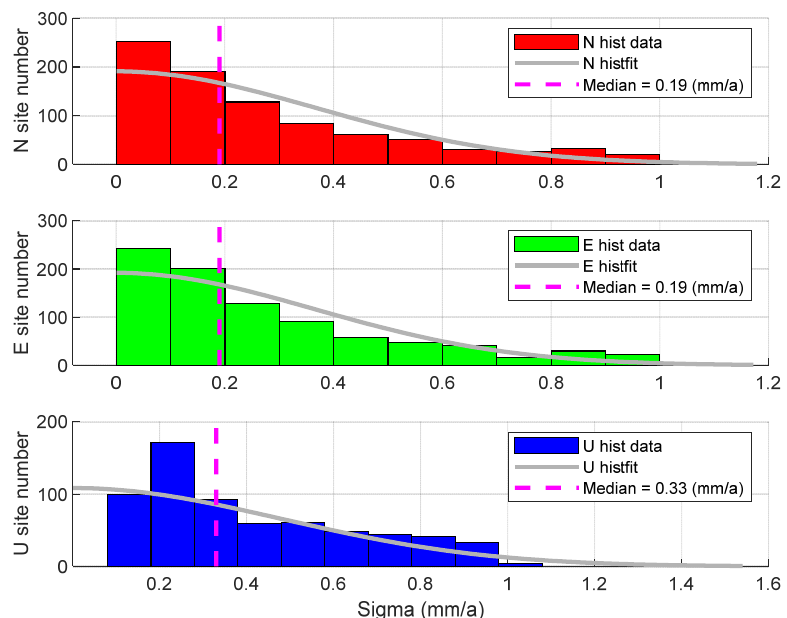
Figure 16. RMSE of global GNSS sites’ velocity fields in the north, east, and up directions.